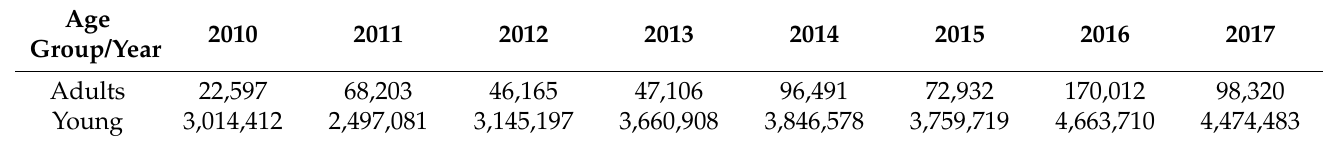
Table 4. Premature mortality cost per group age 2010–2017 (USD 2017).